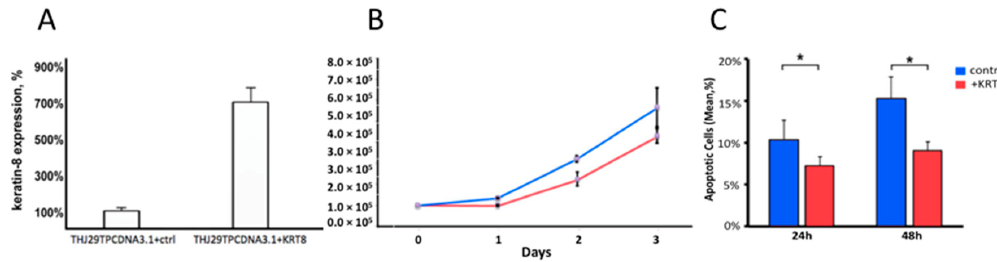
Figure 4. KRT8 expression decreases cell viability but confers resistance to apoptosis under